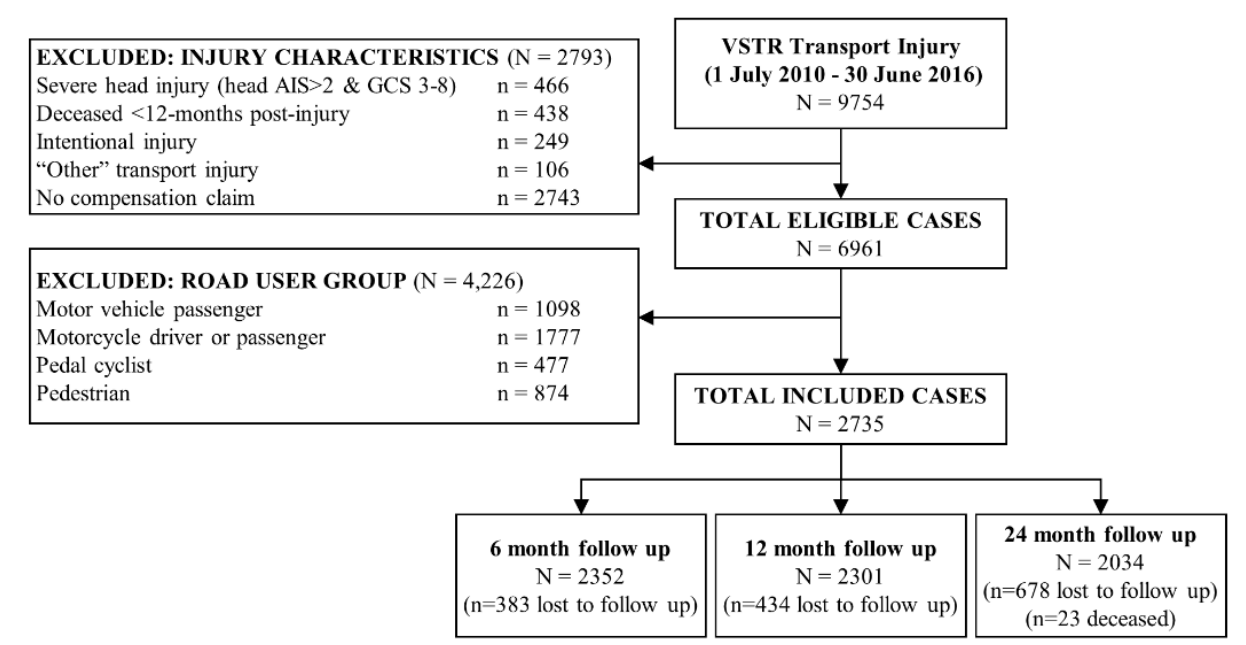
Figure 2. STROBE participant inclusion chart.